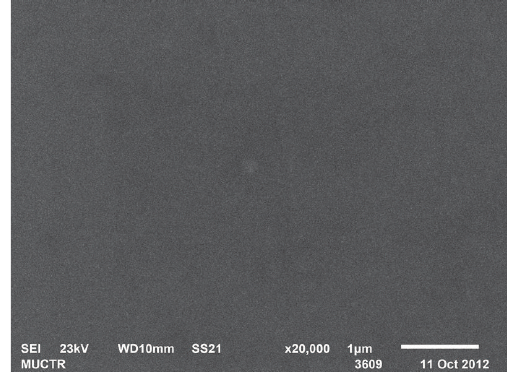
Figure 1: SEM image of typical nanographite film.